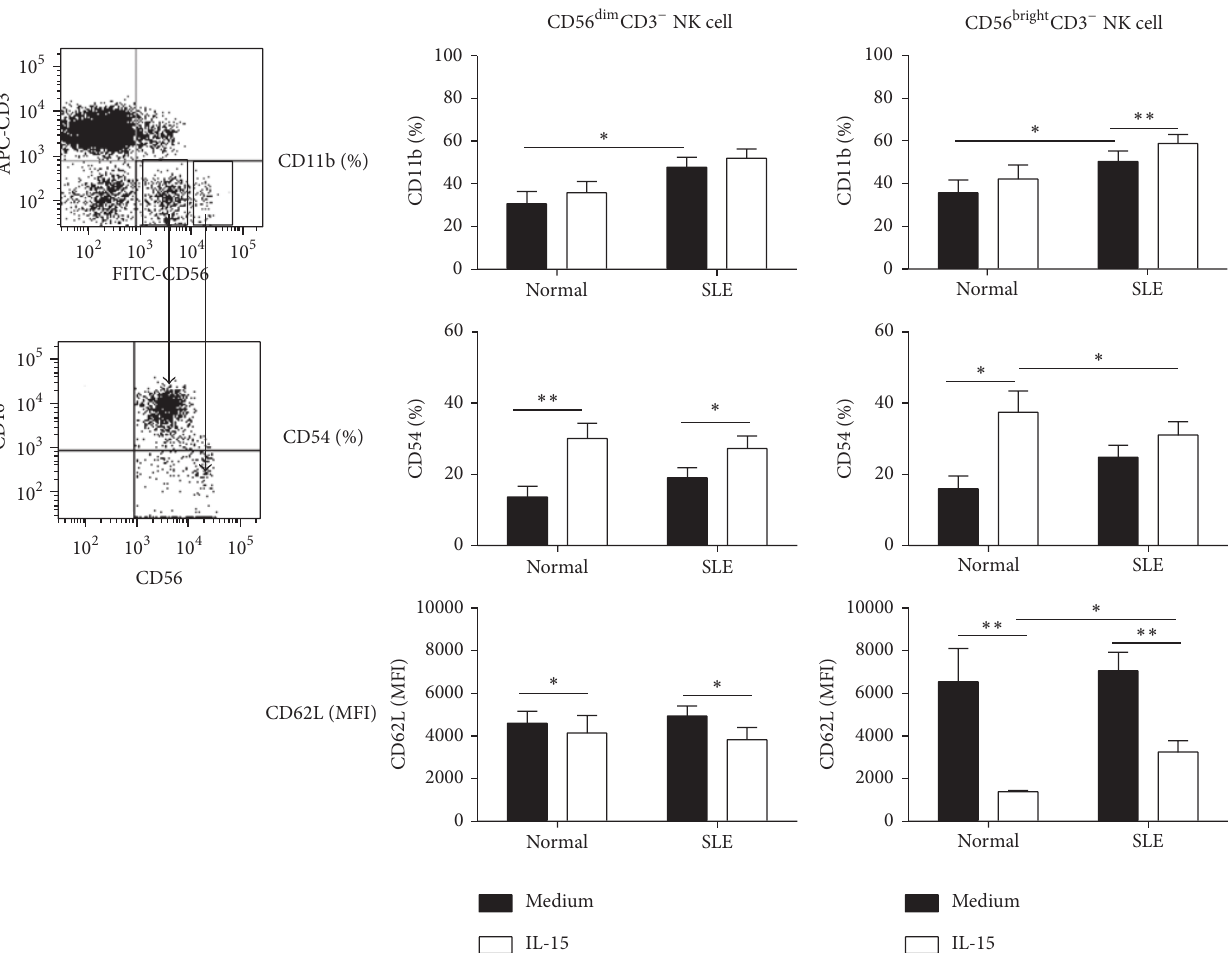
Figure 3: The CD11b, CD54, and CD62L expression on CD 56 dim CD3 − and CD 56 bright CD3 − NK cells from SLE and healthy donors. PBMCs were stimulated with IL-15 (10ng/mL) for 18hrs and stained with anti-CD3 and anti-CD56. A representative profile of how the CD 56 dim and CD 56 bright NK populations were gated under flow cytometry is shown. Data was expressed as percent expression (%) ± SEM. ∗ 𝑝 < 0.05 and ∗∗ 𝑝 < 0.01 (normal, 𝑛 = 10 ; SLE, 𝑛 = 17